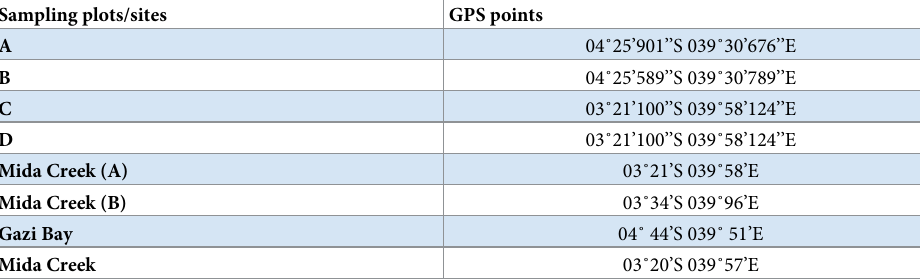
Table 1. A table of GPS co-ordinates of the sampling sites and plots used in this study. Sampling